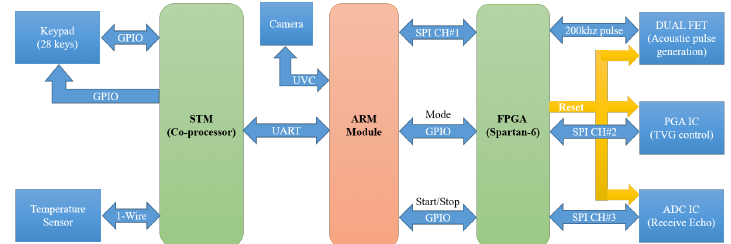
Figure 5. Block diagram of handshaking and communication used by the ARM module with the FPGA and co-processor.